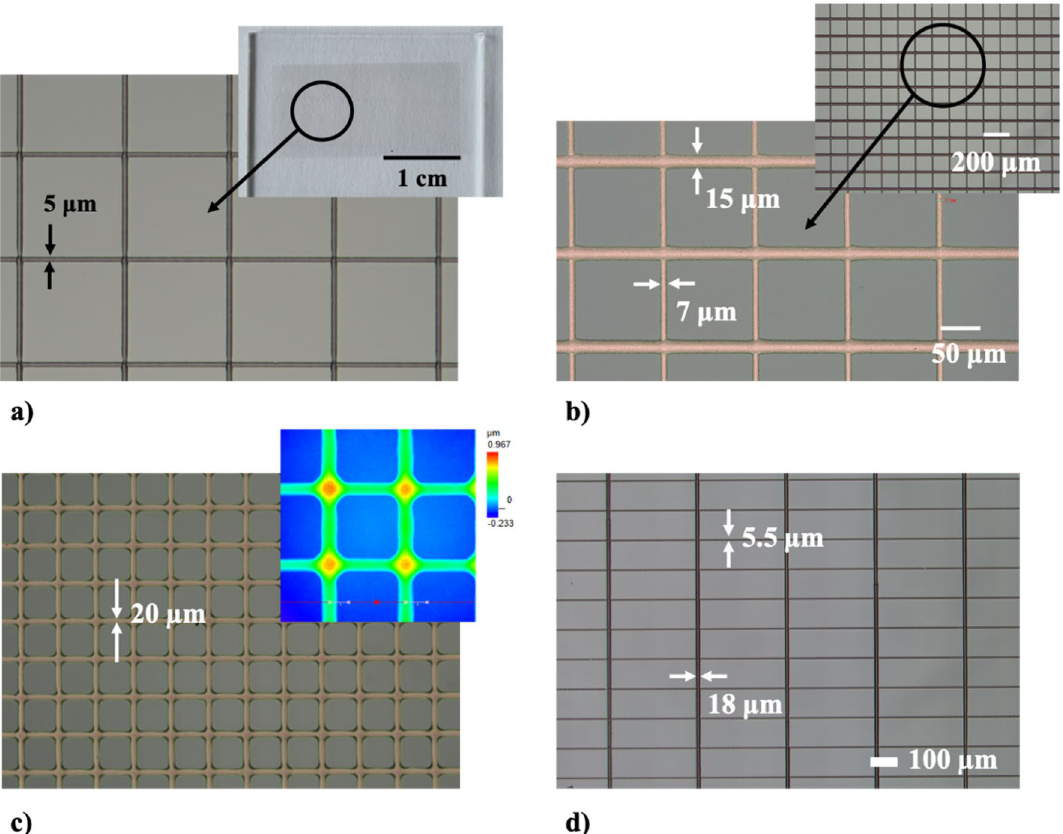
Figure 11. Example conductive meshes printed using highly-concentrated pastes. ( a ) Conductive mesh with 5 μm wide lines, printed using paste based on silver nanoparticles (85 wt% of solid content). The whole sample is shown in the inset; ( b ) conductive mesh printed using copper paste (80 wt% of solid content). The line width is 7 μm (horizontal direction) and 15 μm (vertical direction). The inset shows distant view of the sample; ( c ) conductive mesh printed using gold paste (80 wt% of solid content). In the inset we show a heat map corresponding to the height profile; ( d ) conductive mesh printed on glass/IZO substrate using paste based on silver nanoparticles (85 wt% of solid content). The line width is 5.5 μm (horizontal direction) and 18 μm (vertical